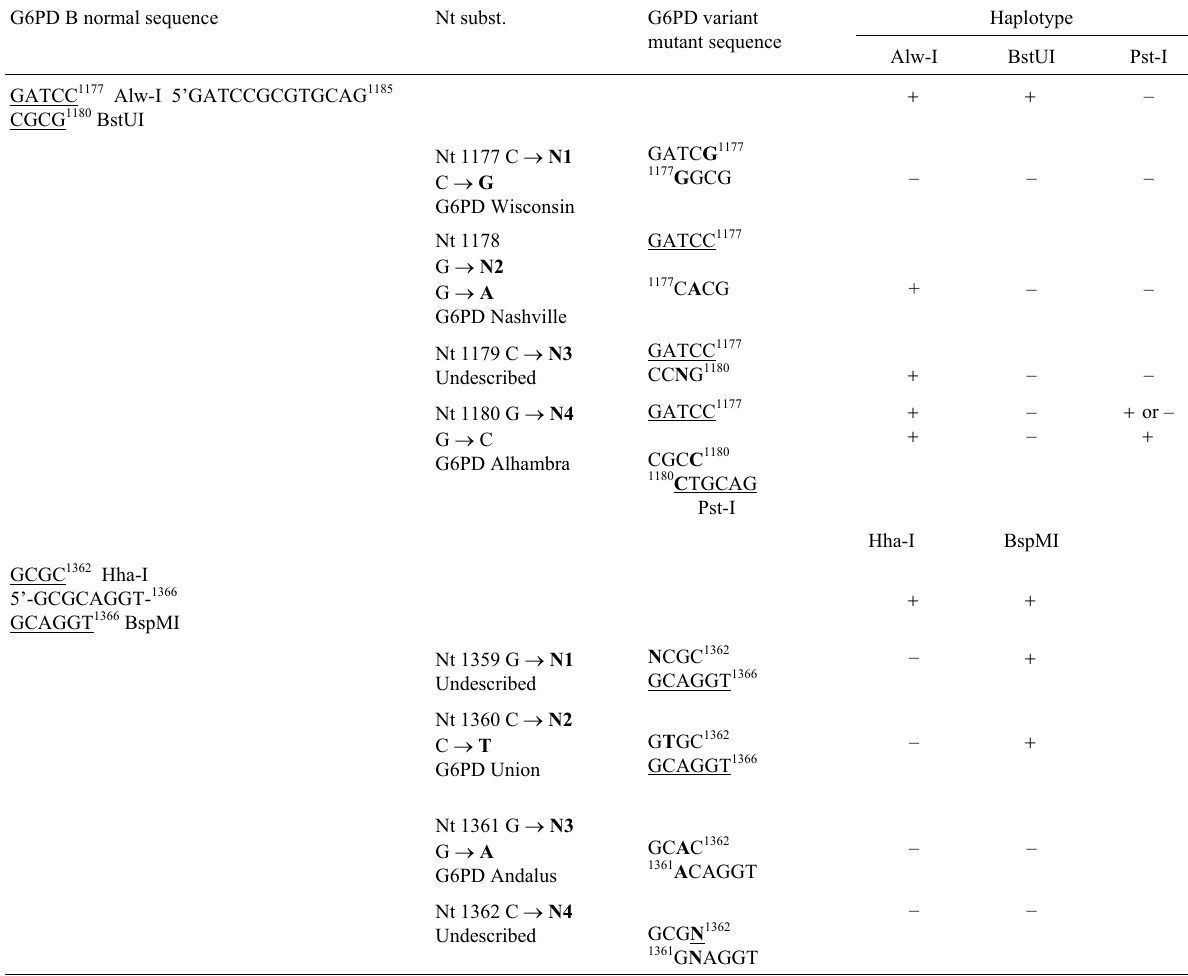
Table2 -PCR-REAgenotypingoftheglucose-6-phosphatedehydrogenase(G6PD)G6PDNashvilleandG6PDUnionvariants.Nucleotidesubstitutions are in bold type and the restriction endonucleases recognition sequences are underlined. G6PD B normal sequence Nt